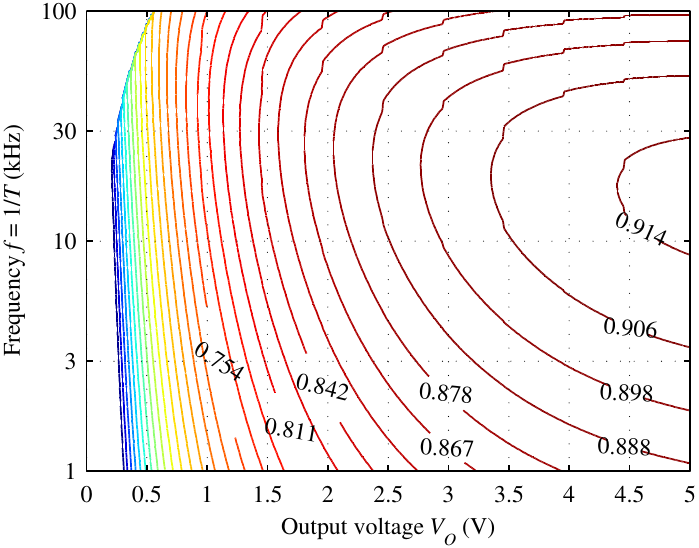
Figure 8. Contour plot of the conversion efficiency corresponding to different values of f and V O , once L = 330µH has been chosen. For this simulation we supposed P IN = 2.0mW, obtainable with the lowest speed used for our tests and with R L = R IN ,eq = 550 Ω